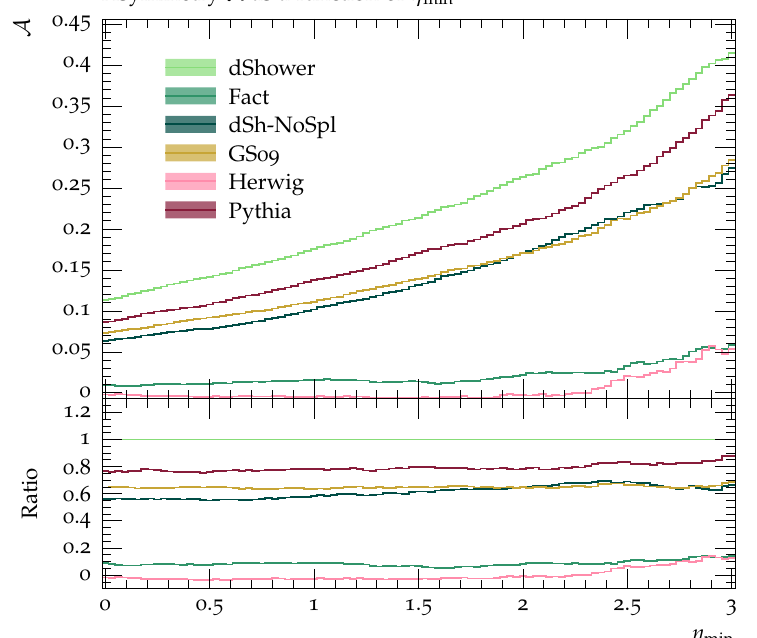
Figure 9 . ( (cid:17) min ) for p s = 14 TeV and for di(cid:11)erent setups. The setup dShower is the reference A in the ratio plot. Recall that there is no shower for the GS09